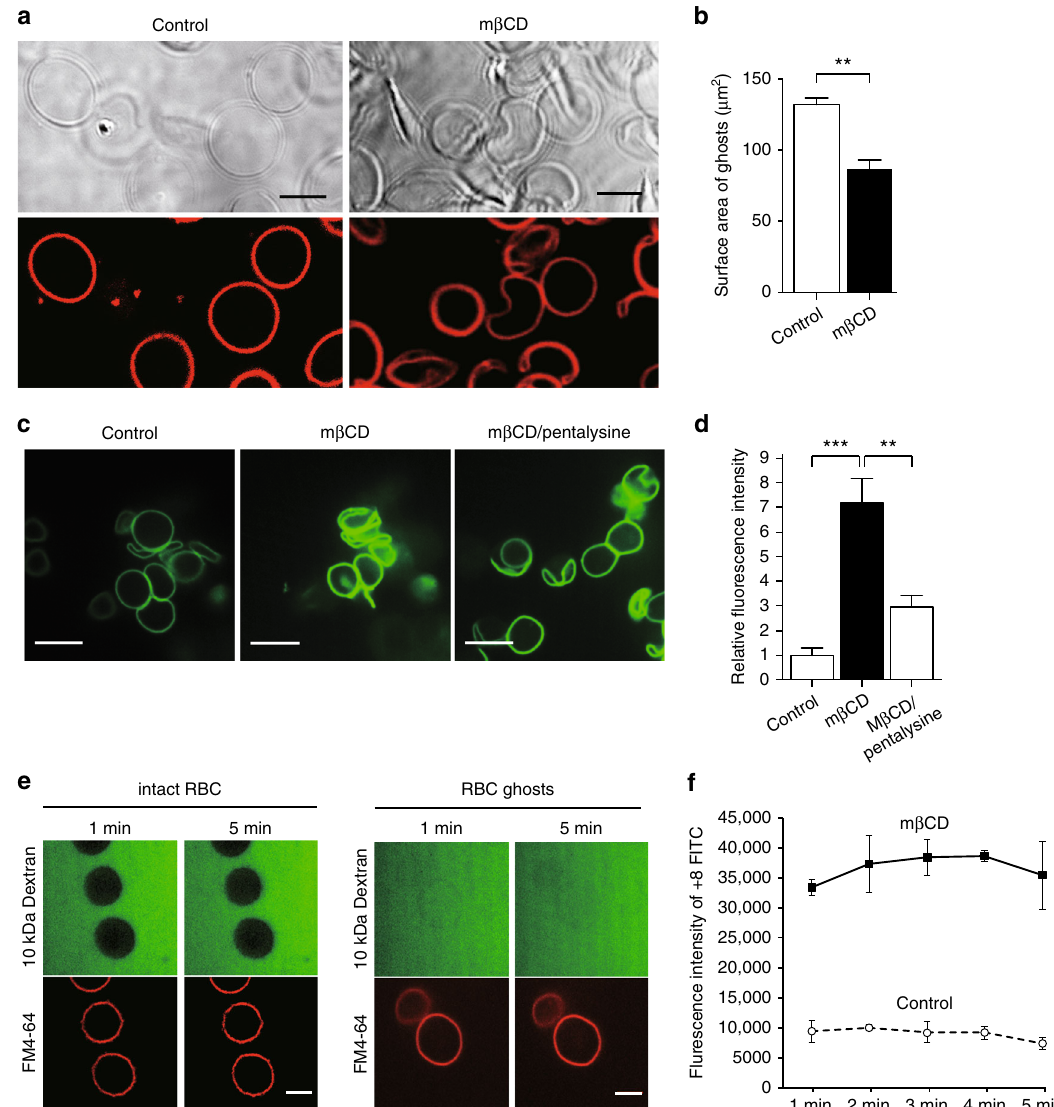
Fig. 3 Cholesterol removal decreases surface area and increases the surface charge. a DIC (top) and fl uorescence (bottom) images of RBC ghosts acquired by laser scanning microscopy. Ghosts before (left) and after (right) treatment with 10 mM m β CD for 1 min were labeled with 20 ng/ µ L FM4-64. Scale bar = 5 µ m. b Surface area (in µ m 2 ) of control and cholesterol-extracted ghosts. Data are means ± s.e.m., n = 20. c Representative images of FITC-tagged polycationic peptides electrostatically bound to the ghost cytosolic lea fl et. Ghosts were bathed in 5P8 containing 6 ng/ μ L diluted peptides (left), and treated 10 mM m β CD for 1 min (middle), and with m β CD treatment after a preincubation with 1.5 mM pentalysine (right). d Relative fl uorescence intensity of +8-FITC peptide bound to RBC ghost before or after m β CD treatment, with or without preincubation with pentalysine. The intensity of ghost membrane fl uorescence was measured with ImageJ. Values represent the means ± s.e.m., n = 41. e Permeability of intact RBCs and ghosts to fl uorescein conjugated 10 kDa dextran was assessed. Confocal images demonstrate the inability of dextran to enter intact RBCs and freely entering ghosts. f Time course of +8-FITC binding to the inner lea fl et of control of cholesterol-depleted ghosts. The intensity of the membrane fl uorescence was measured with ImageJ. Data represent the means ± s.e.m., n = 3. NS = not signi fi cantly different, *p < 0.05, **p < 0.01 and ***p < 0.005; as determined using a two-tailed t-test. Scale bar = 10 µ (Supplementary Fig. 3D and refs. 17, 18 ), the fl uorescent probe was added to the ghosts after the cholesterol was extracted. After treatment with m β CD, the surface area declined to 87 µ m 2 , i.e. a ≈ 35% reduction in surface area (Fig. 3a, b).